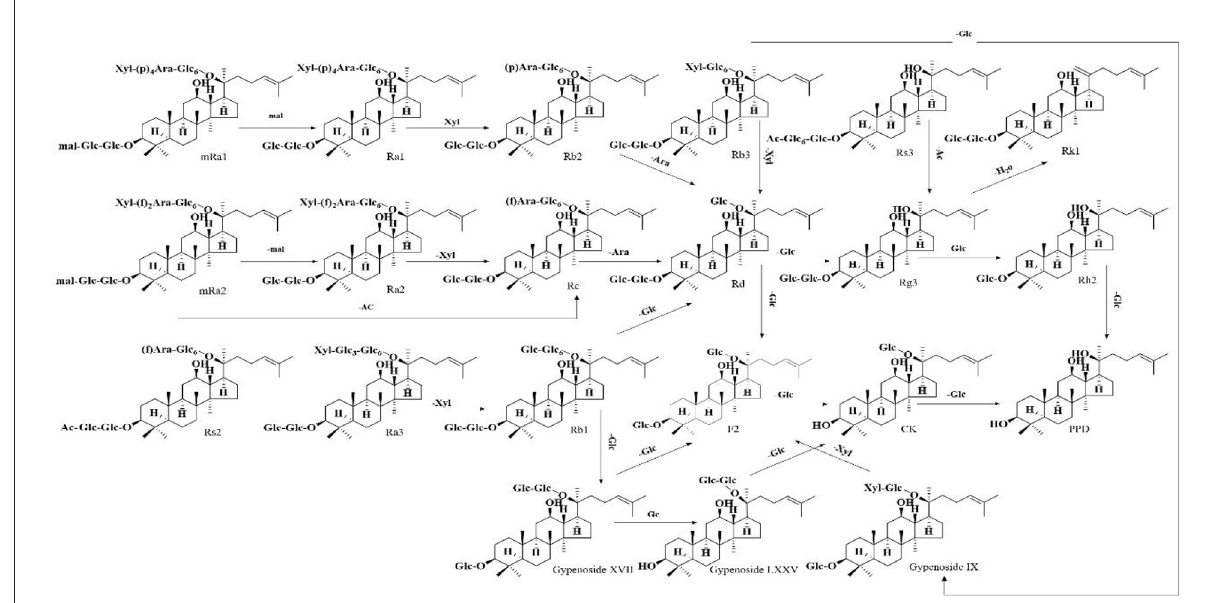
FIGURE3 Possible transformation pathways of PPD-type ginsenosides under the action of GH.